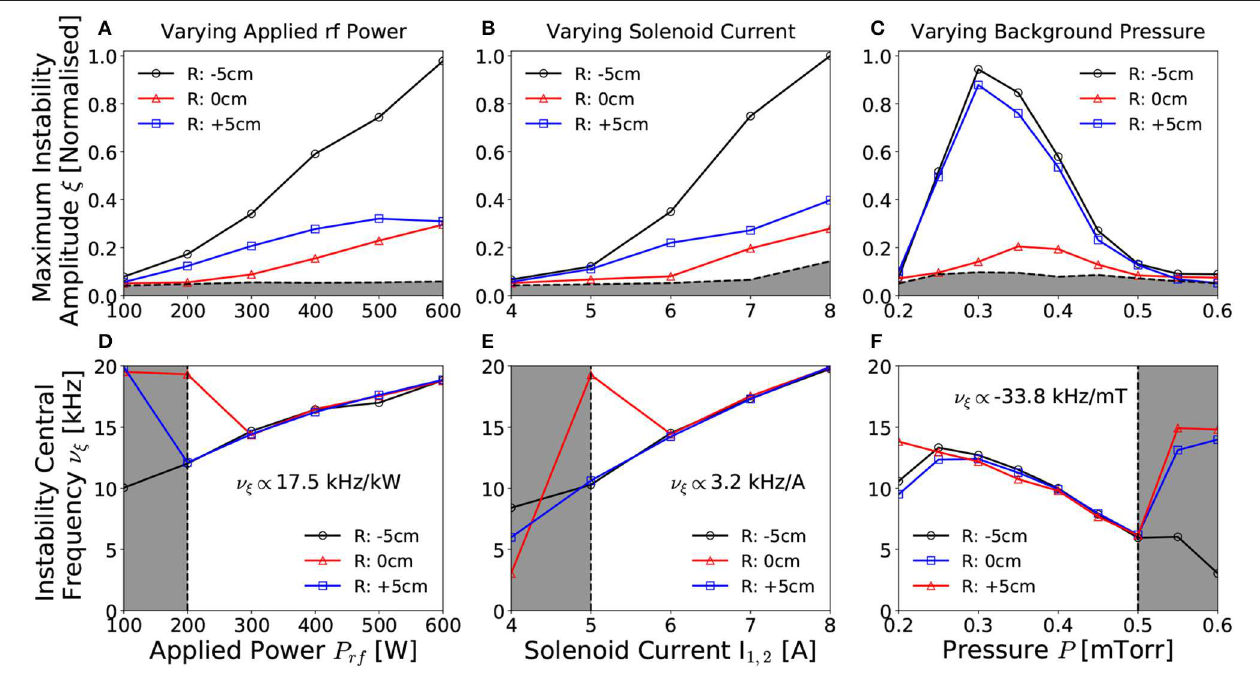
FIGURE 4 | Normalized instability amplitude and frequency with respect to (A,D) rf power P rf , (B,E) solenoid current I 1,2 and (C,F) operating argon pressure respectively, as measured on-axis ( R = 0.0 cm) and off-axis ( R = ± 5 cm), Z = 2 cm downstream of the DL. Off-axis measurements correspond to the beam-conic interface, correlating with the region of highest radial ion density gradient. The horizontal gray shaded regions in (A–C) denote the background noise level, while the vertical gray shaded regions in (E–F) denote measurements for which SNR ≤ 2. Solid lines added to guide the eye. Operating conditions: helicon antenna supplied P rf = 100 − 600 W at ν rf = 13.56 MHz employing 0.2–0.6 mTorr argon with I 1,2 = 4 − 8 A solenoid current.